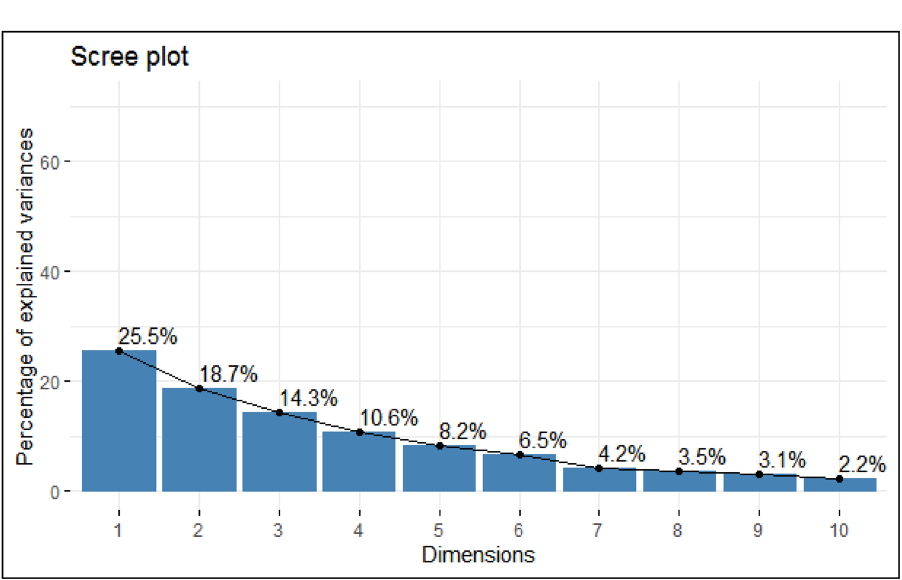
Figure 2. PCA predicting percentage of the variance depicted by first ten principal